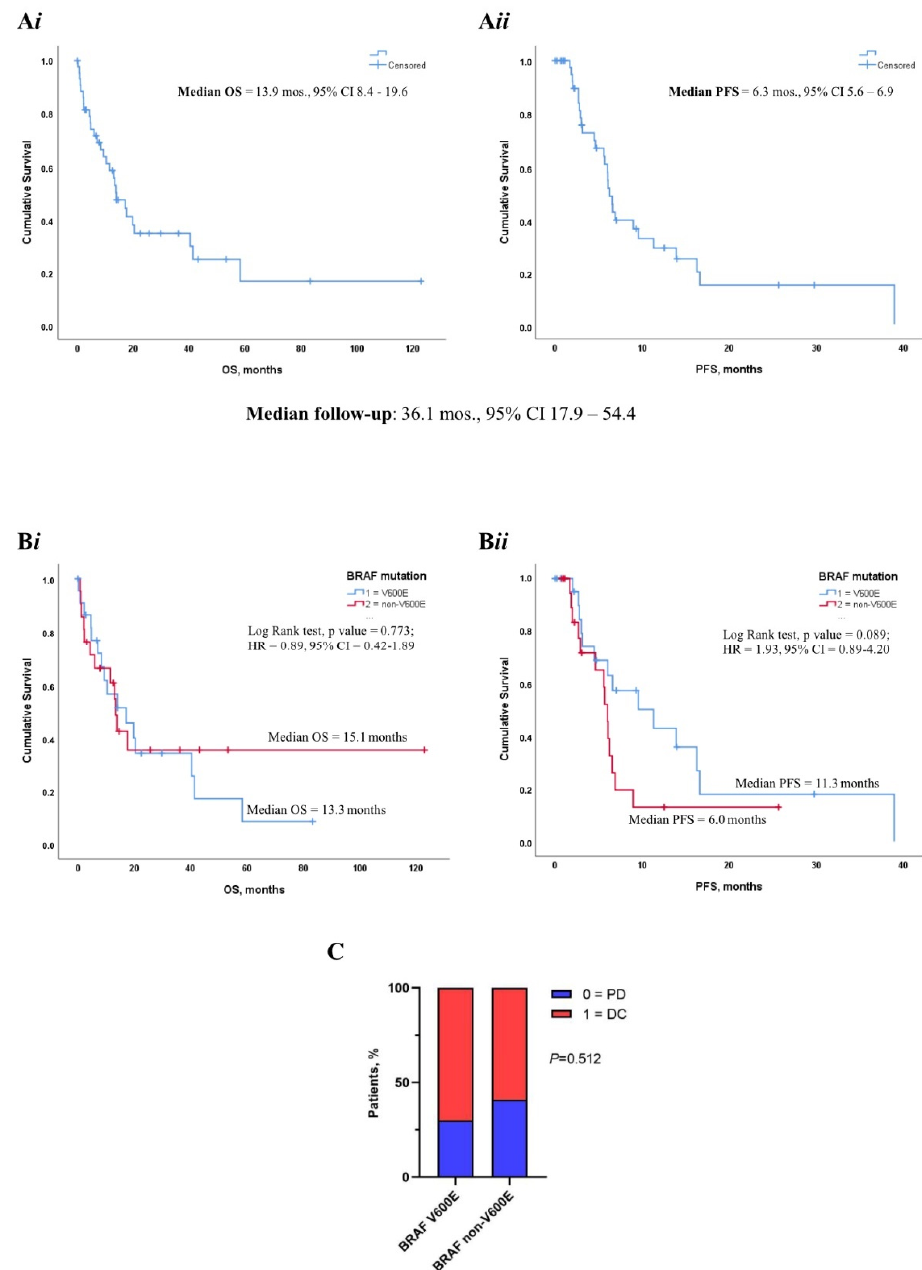
Figure 2. ( A i , A ii ) Median overall survival (OS) and progression-free survival (PFS) in the overall population. ( B i , B ii ) Kaplan Meier survival curves illustrating the survival outcome according to BRAF mutational status (V600E vs. non-V600E). ( C ) Stacked charts showing the treatment response sponse (DC vs. PD) in BRAF V600E vs. non-V600E subsets. DC = CR + PR + SD ≥ 6 months; (DC vs. PD) in BRAF V600E vs. non-V600E subsets. DC = CR + PR + SD ≥ 6 months; PD = PD + SD < 6 months. PD = PD + SD < 6